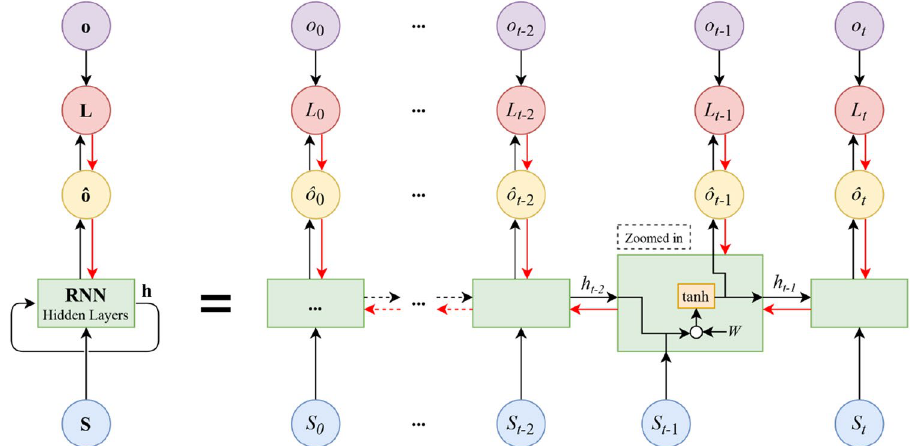
Figure 2. The block diagram of the RNN learning system is shown in rolled (left) and unrolled (right) configurations. The black arrows illustrate the forward propagation path, whereas the red arrows depict the backpropagation path. A zoomed view of a sample hidden layer is shown to display the detailed internal